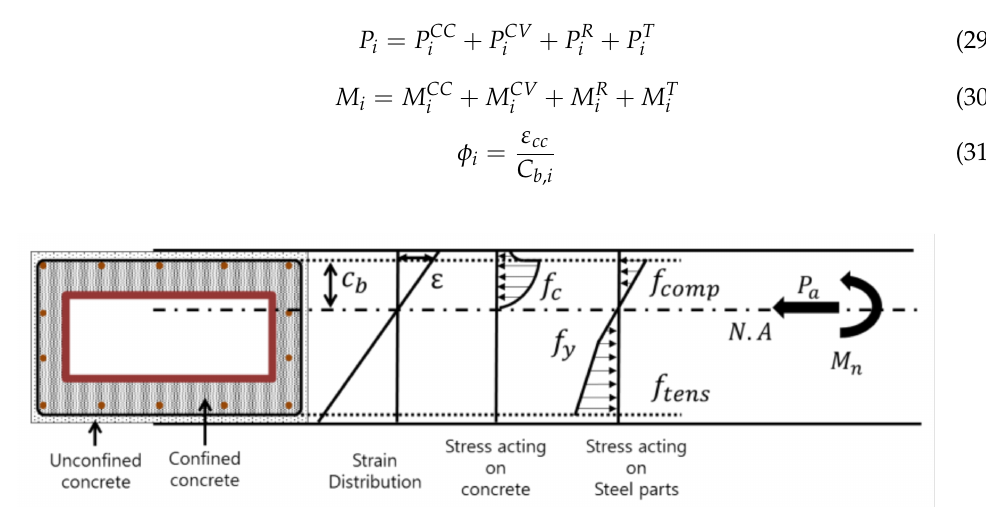
Figure 5. Section analysis using strain compatibility and layer-by-layer